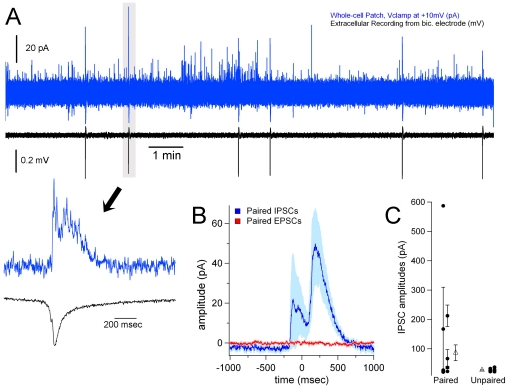
Injection of bicuculline in one hemisphere results in bursts of IPSCs in the contralateral hemisphere.(A) Fifteen minutes of a representative recording of IPSCs (blue trace) and EEs (black trace) are shown (same format as Fig. 6Bii, although this is from a different recording). A temporally magnified view is shown of a single EE-IPSC pair, as indicated by the highlighted region and arrow. Note the long duration of the IPSC (>200 msec) and significantly large amplitude of this event (largest in the entire recording), indicating that the event probably results from a burst of IPSCs. (B) EE-triggered averages of voltage clamp recordings. Time 0 represents the time of onset of a contralateral EE. Only recordings where putative correlated PSCs were found were included in the averaging. Number of extracted windows averaged: IPSCs, n = 26 from 8 slices; EPSCs, n = 30 from 3 slices. The shading represents the ± SE. (C) The mean ± SE for IPSC amplitudes are shown from each neuron as dots, and they are separated into two groups: IPSCs that were paired with a contralateral EE, and IPSCs that were not paired with a contralateral EE. The triangles represent the mean of means for each group, showing a significant difference in the amplitudes of paired vs. unpaired IPSCs (p<0.01 rank sum test).